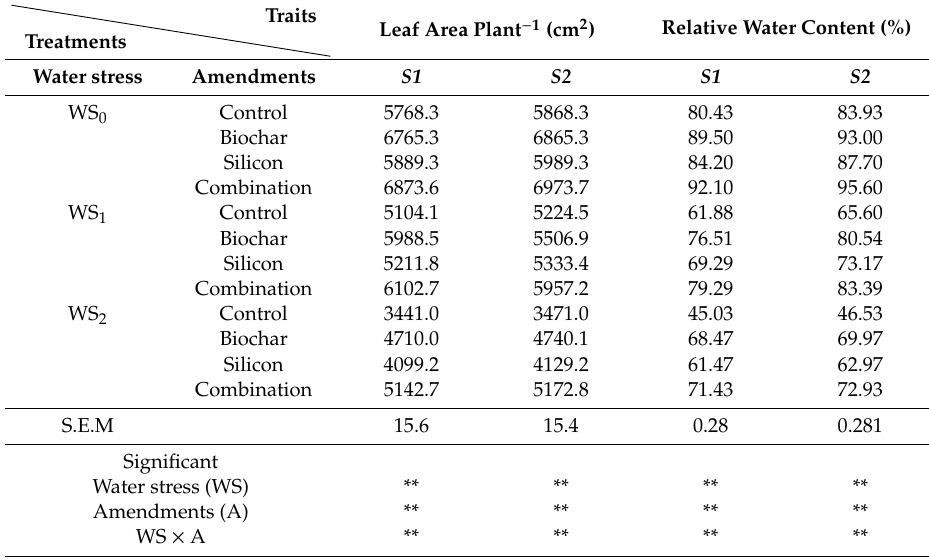
Figure 2. Effect of biochar and silicon amendments on growth of sunflower under water deficit stress treatments. Bars = Standard error of means (S.E.M.), WS 0 = well-watered plants (50% depletion of the available soil moisture; DAM), WS 1 = Moderate stress (70% DAM), WS 2 = Severe stress (90% DAM). Table 3. Interaction effect of amendments and water deficit stress treatments on leaf area per plant and relative water content of sunflower during two growing seasons 2016 and 2017.